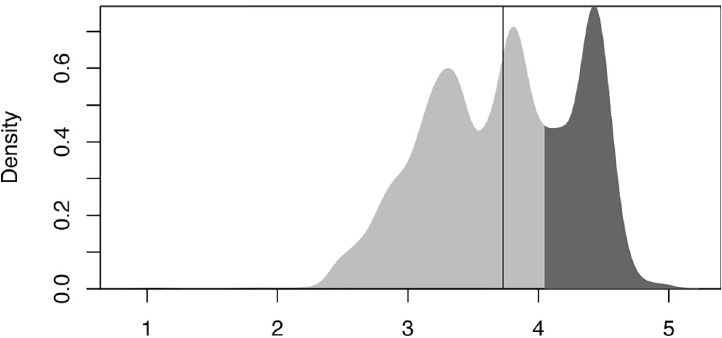
Fig 2. PDF of Gross Cell Product per capita. Probability Density Function (PDF) for log 10 of GCP-PC. The black vertical line shows the mean of the distribution which is 3.73 (equivalent to about $5350/person). The PDF displays an interesting tri-modal behaviour (cf. also Fig 1): the first mode (between 3.05 and 3.55) corresponds to most of East and South Asia, Central-Northern Brazil, and parts of Western Africa; the second mode (between 3.55 and 4.1) covers Eastern Europe, Northern and Southern Africa, most of Central America and the rest of South America; the third mode (between 4.1 and 4.65) covers North America, Western Europe, parts of Russia, the Arabian peninsula, Japan and coastal Australia. The darker grey denotes the upper